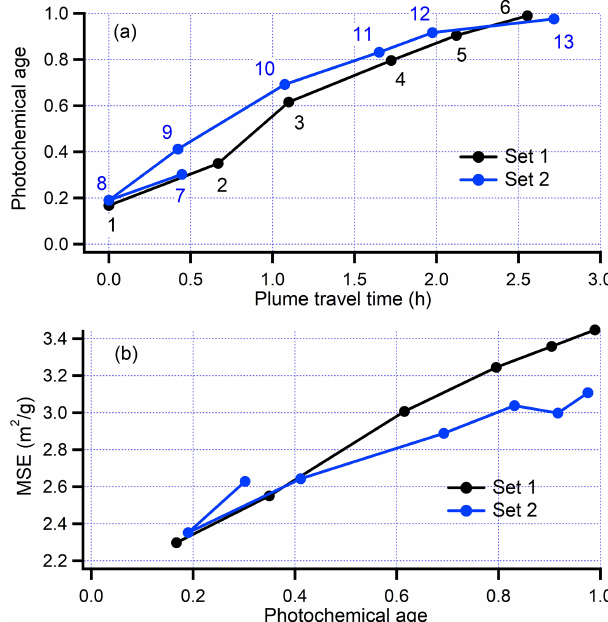
Figure 4. Transect-average data from flight 730b. Lines join tran- sects in order of increasing time. Transects correspond to plume crossings shown in Fig. 3. Set 1 consisted of transects 1–6 at in- creasing photochemical age. The seven transects (7–13) of Set 2 start at a photochemical age = 0 . 3 and proceed to 0.2, 0.4 0.7, 0.8, 0.9 and 1.0. The transition between Set 1 and Set 2 was outside the smoke